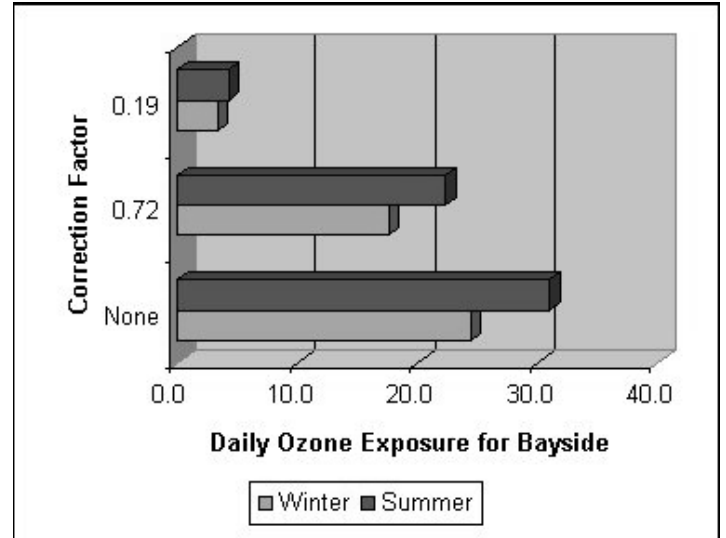
Figure 11. Adjusted ozone exposure for Bayside (millions of persons-ppb)